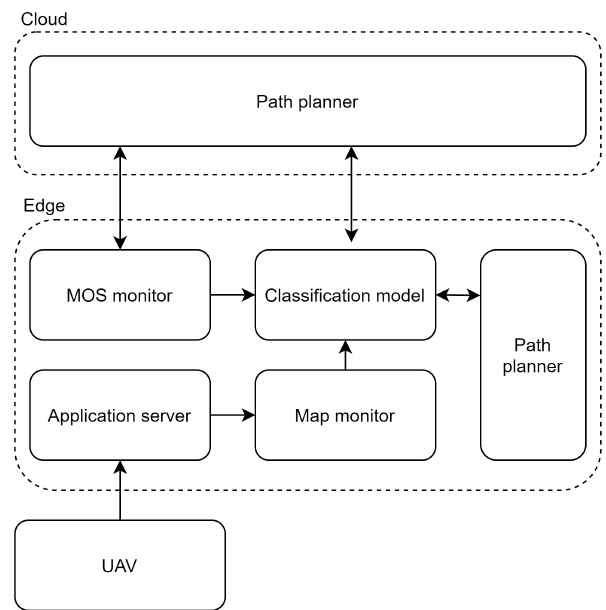
Figure 8. Architecture of the designed